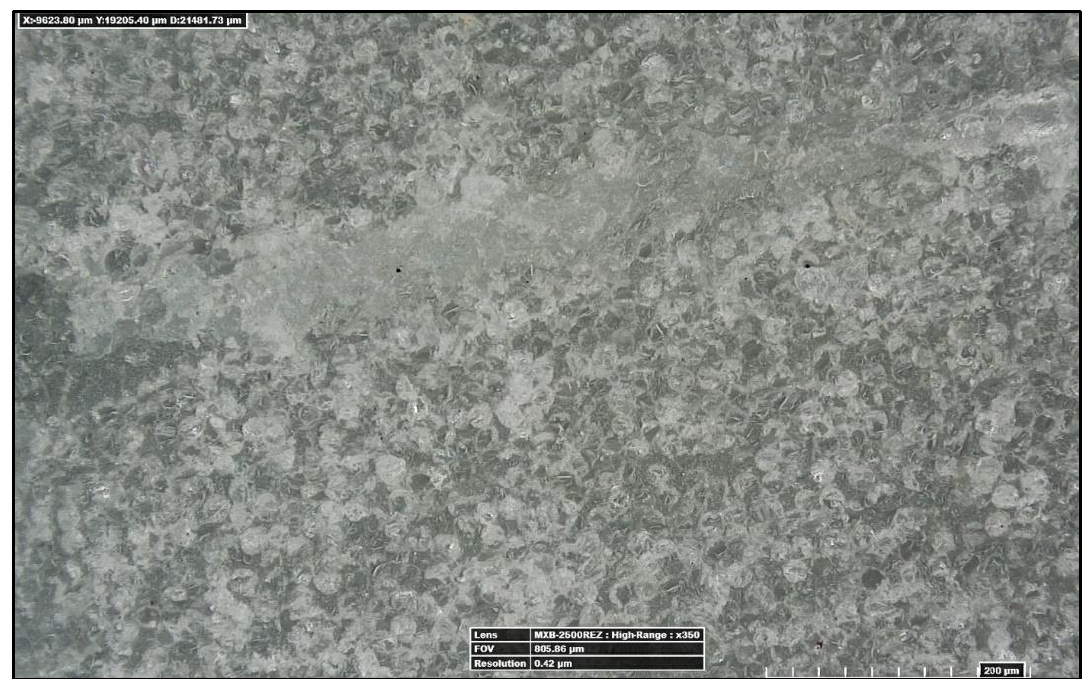
Figure 6. R-glass FRP plate with a ( bottom ; ×350 magnification) transverse and ( top ; ×140 magnification) hoop fiber orientation after a week of exposure to pH 7.0 aqueous solution.